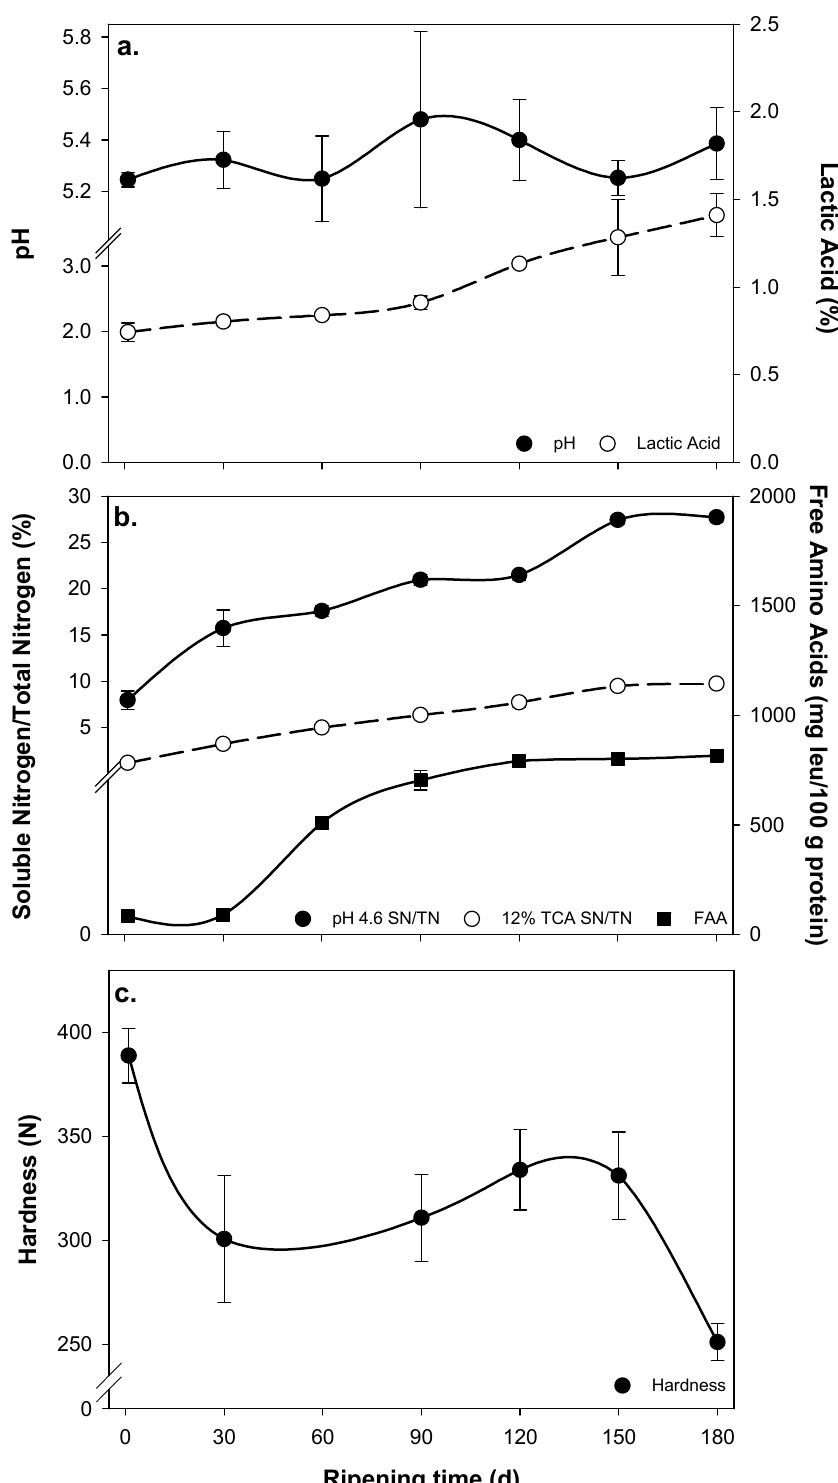
Figure 1. Changes in levels of pH values and lactic acid ( a ); proteolysis expressed as pH 4.6-soluble N (pH 4.6 SN/TN), 12% trichloroacetic acid-soluble N (12% TCA SN/TN) and free amino acids (FAA; ( b )), and hardness estimated by uniaxial compression test ( c ) throughout ripening of Mexican Manchego-style cheese produced from Pelibuey ewes milk. Values represent mean and standard deviation of three replicate trials.